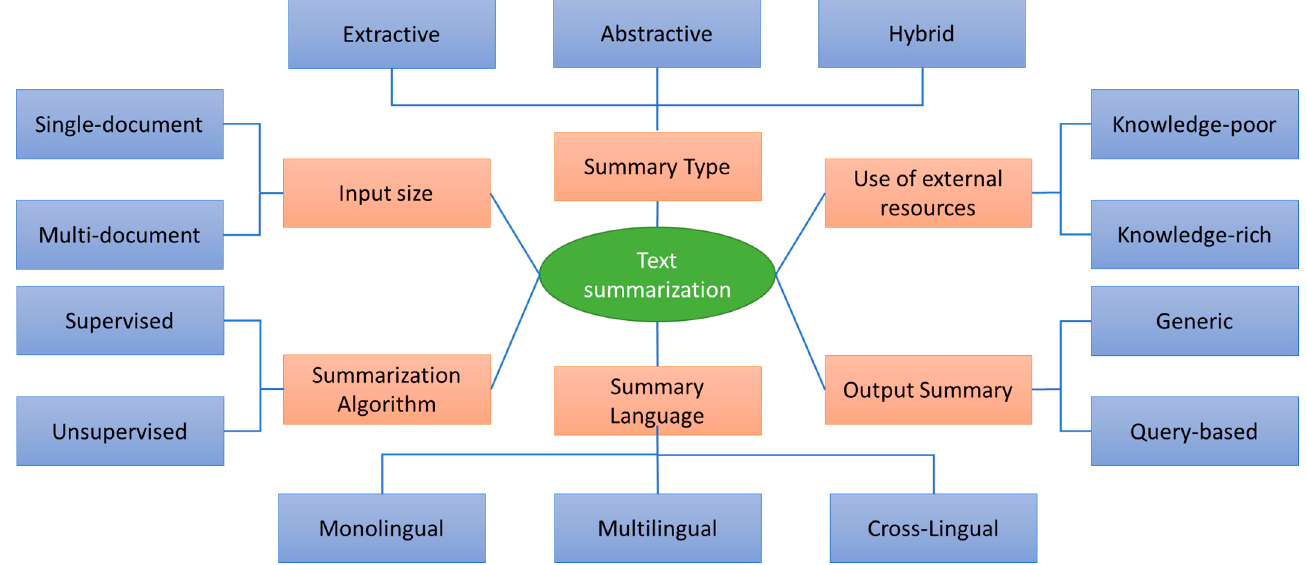
Figure 1. Classification of text summarization systems adapted from [2].